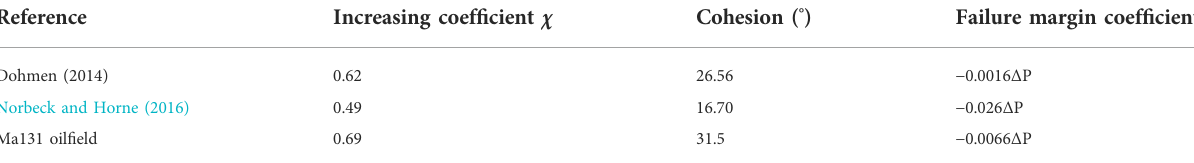
TABLE 2 Published geomechanical data and Ma131 oil fi eld data related to the failure margin coef fi cient (Dohmen et al., 2017).